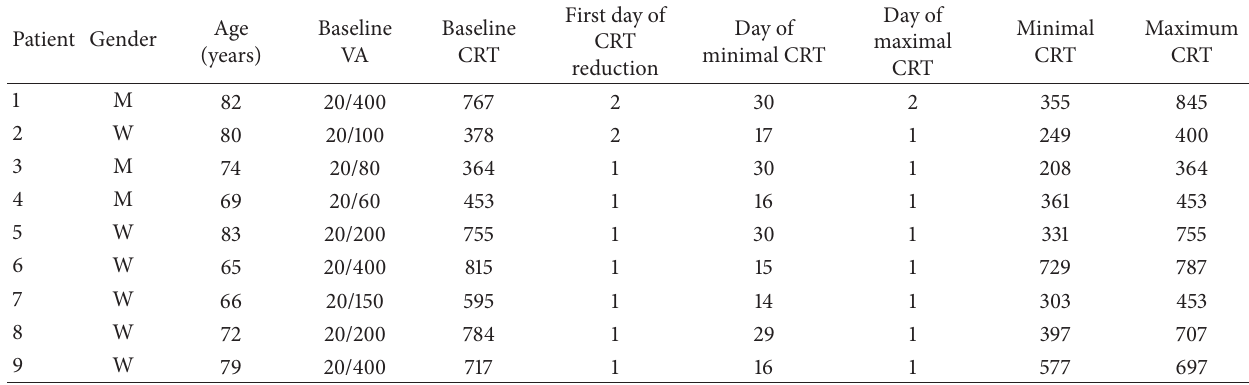
Table 1: Patient